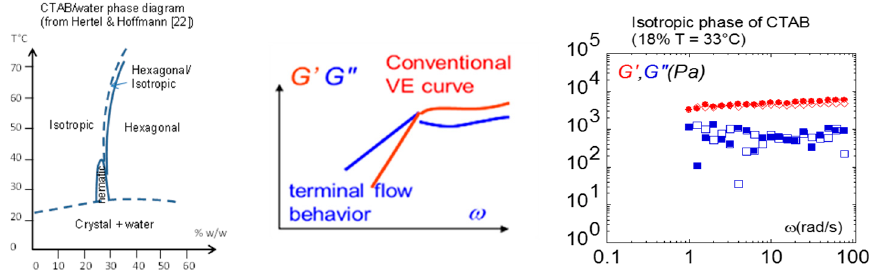
Figure 12. Using total wetting conditions, the liquid phase (dilution 18%) of salt-free CTAB-water (Cetyl TrimethylAmmonium Bromide solution) measured at 33 °C (isotropic phase) and the 0.300-mm gap thickness exhibit solid-like behavior with G’ independent of the frequency and exceeding G’’ [51].